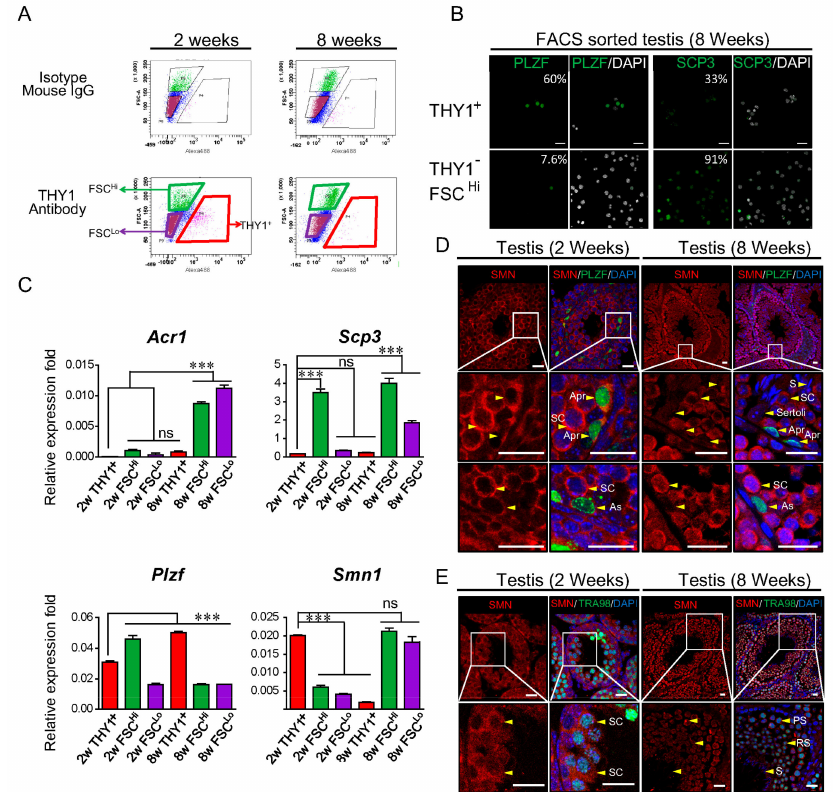
Figure 1. The distribution of survival motor neuron (SMN) in young and adult mouse testes. ( A ) Fluorescence-activated cell sorting (FACS) was used to characterize and sort testicular cells from 2- and 8-week-old mice. Based on the staining intensity of Thy-1 Cell Surface Antigen (THY1) conjugated with Alexa-488 fluorescent dye, three populations were identified: SSC (THY1 + ), spermatocyte (THY1 − FSC Hi ), and sperm / spermatids / spermatocyte (THY1 − FSC Lo ). Rat Immunoglobulin G (IgG) subsequently conjugated with 488 was used as the isotype control antibody. ( B ) Sorted THY1 + cells from 8-week-old mice express a high percentage (60%) of promyelocytic leukemia zinc-finger (PLZF) (green, left panel), whereas THY1 − FSC Hi cells shows a low percentage of PLZF signal (7.6%). The meiotic marker synaptonemal complex protein 3 (SCP3) was used to characterize the THY1 − FSC Hi population, which mostly contains spermatocyte. The percentages of markers in di ff erent populations are indicated. ( C ) Determination of the expression level of Smn1 and germ cell markers in the sorted population. In the THY1 + SSC population, Smn1 showed a significantly higher expression level in 2-week-old cells (2w THY1 + ) but decreased to a lower level in the THY1 − FSC Hi spermatocyte population (2w THY1 − FSC Hi ). In 8-week-old THY1 + SSC cells (8w THY1 + ), the expression level of Smn1 showed no di ff erence compared to the spermatocyte population of 2-week-old cells but increased significantly in the THY1 − FSC Hi spermatocyte population (8w THY1 − FSC Hi ). The transcript expression level of the spermatogonia-specific marker Plzf , sperm marker Acr1 , and meiotic marker Scp3 showed a cell-type-dependent manner. The error bar indicates technical repeats. The expression level of each group was compared with the 2w THY1 + group. *Indicates significance, p < 0.05; **, p < 0.005. ( D ) Putative proliferating A-paired spermatogonia (Apr, arrowhead, upper, and middle panel) expresses the abundant amount of SMN in the testis of both 2- and 8-week-old mice, whereas